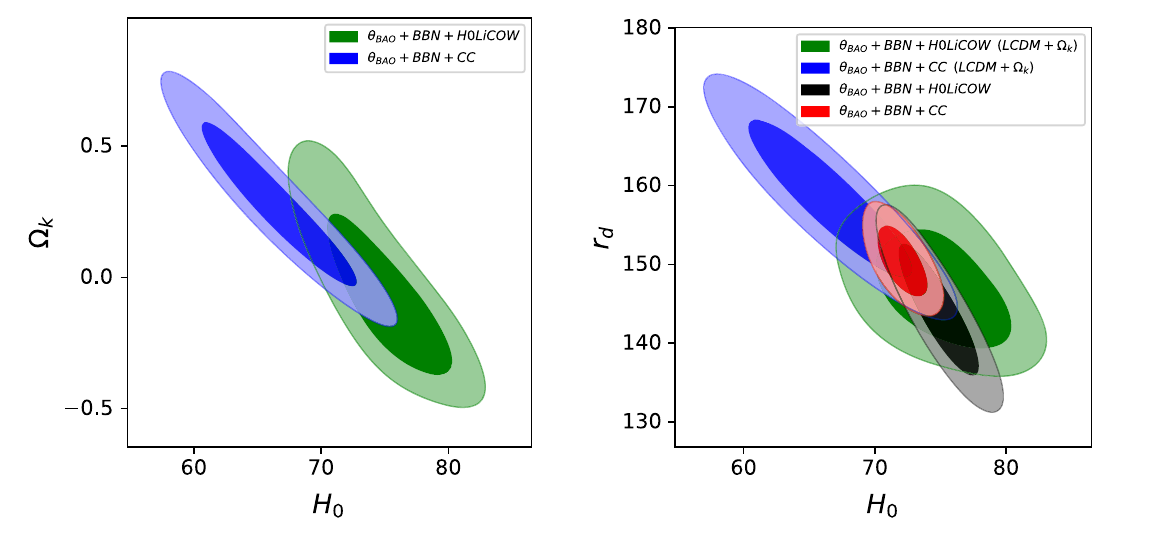
plane from the analyses with and without the (cid:3) k parameter. The H 0 parameter is measured in units of km s − 1 Mpc − 1 and r d in